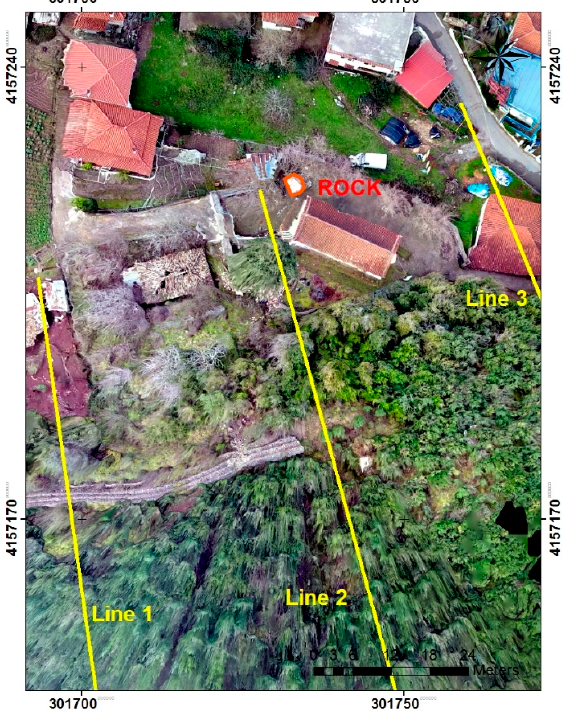
Figure 10. Picture of the rockfall in Platiana region, illustrating the final position of the rock.